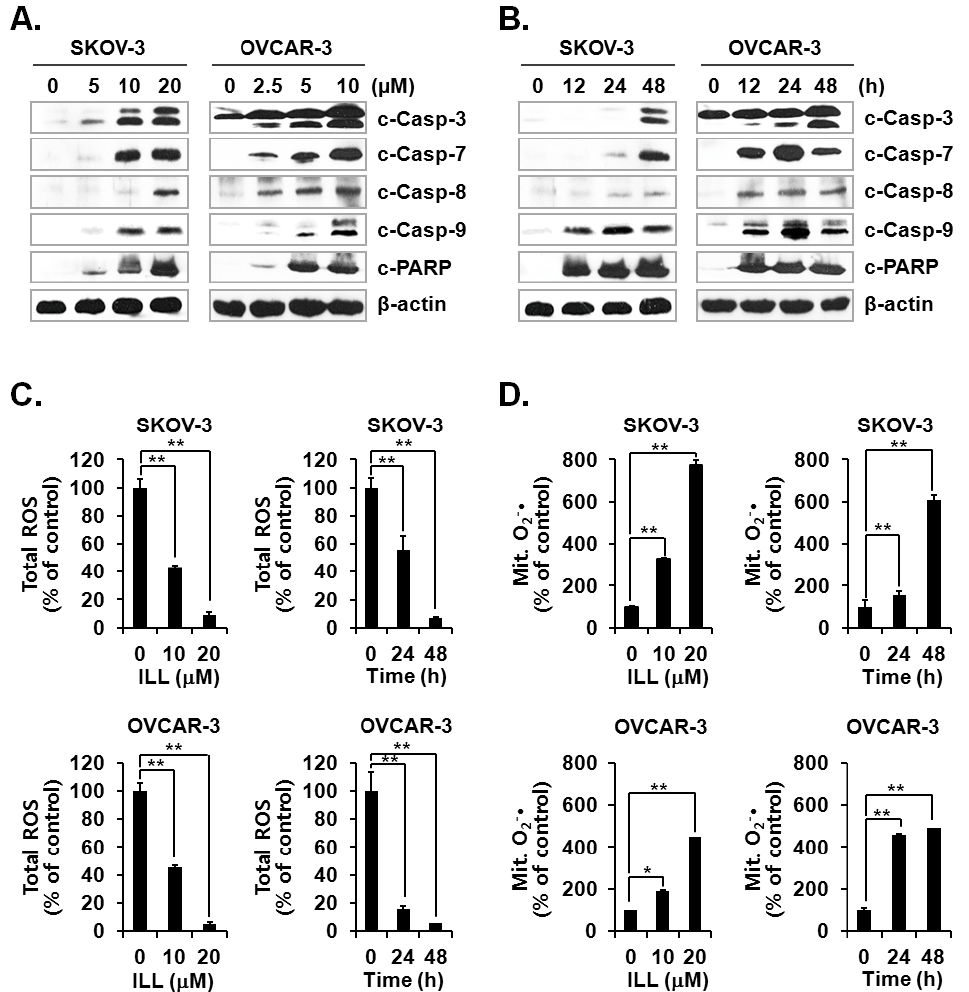
Figure 2. Activation of caspases and changes in cellular and mitochondrial ROS levels after ILL treatment. ( A , B ) ILL treatment proteolytically activated caspase-3, -7, -8, and -9, and cleaved poly (adenosine diphosphate-ribose) polymerase (PARP) in a time- and dose-dependent manner. Intracellular levels of reactive oxygen species (ROS). ( C ) and mitochondrial superoxide (mtSO). ( D ) were detected by dichlorodihydrofluorescein diacetate (DCF-DA) and mitoSOX using fluorescence-activated cell sorting (FACS). Values are presented as the mean ± SD of triplicate samples. * p < 0.05 and ** p < 0.001 vs. the control